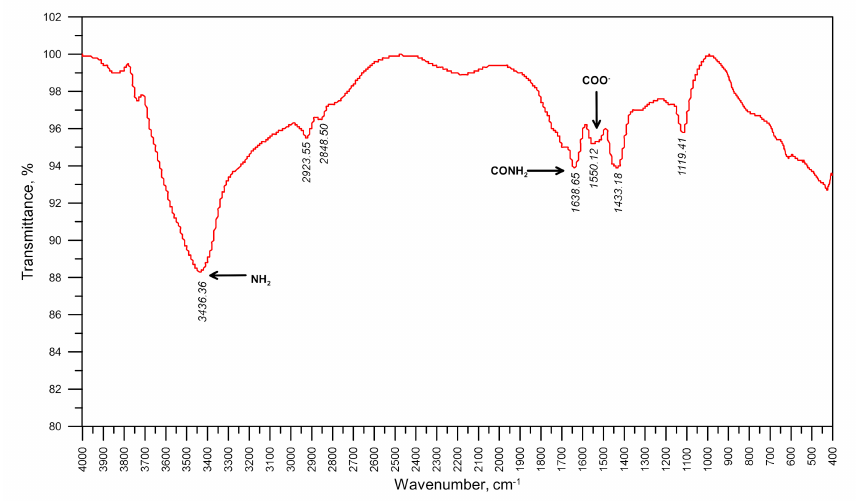
Figure 3. FTIR spectra of PAM